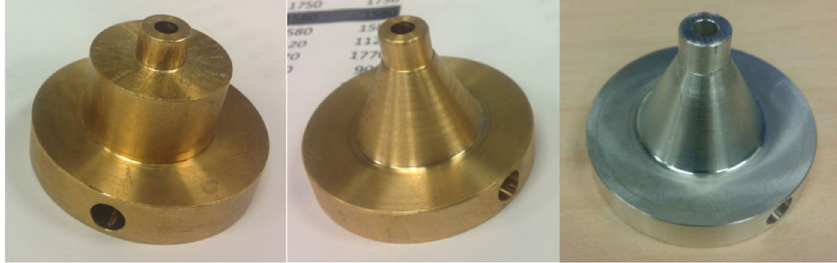
FIG. 10. From left to right, the weight part photos of the 120 (original), 85, and 60 g damper